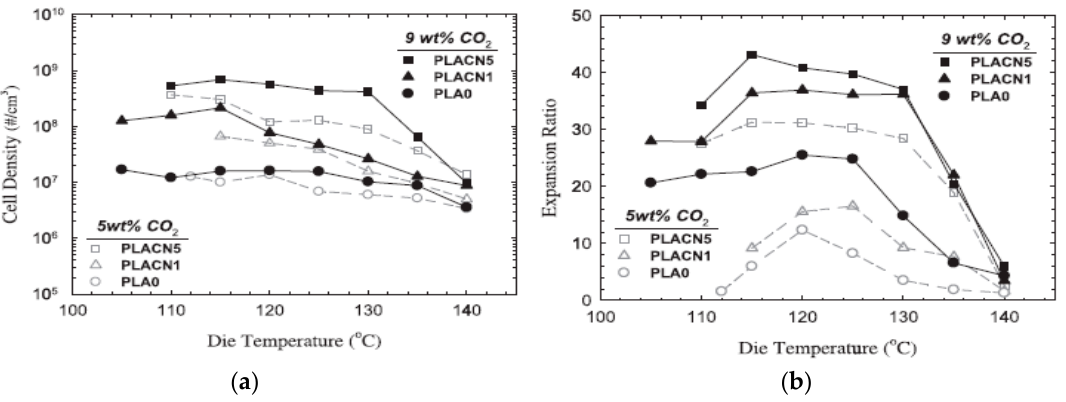
Figure 32. Comparison of ( a ) cell density and ( b ) expansion ratio of foams obtained at various die temperatures with 5 and 9 wt% CO 2 from neat PLA (PLA0) and PLA with 1 wt% (PLACN1) and 5 wt% (PLACN5) of Cloisite 30. Reprinted from Keshtkar et al. [151]. Copyright (2020), with permission from Elsevier.